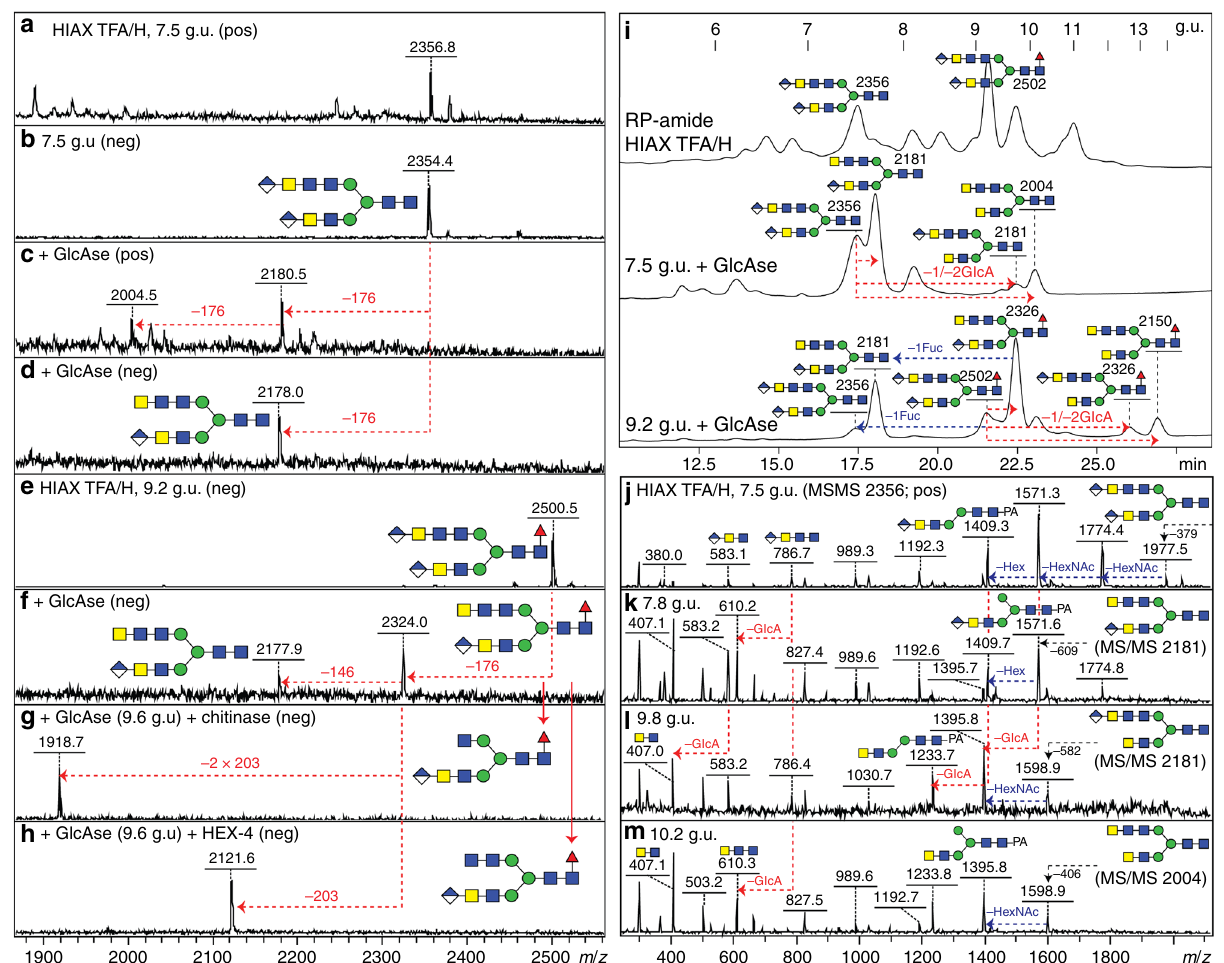
Fig. 8 Effect of glucuronidase treatment on diglucuronylated N-glycans. a – f Two RP-amide HPLC example fractions from anionic HIAX pool H (see Fig. 5) were treated for 75 min with a commercial H. pomatia β -glucuronidase (GlcAse) prior to re-analysis by MALDI-TOF – MS (see also chromatograms in i ) showing removal or one or two glucuronic acid residues (losses of 176 Da) as well as, due to an impurity in the enzyme preparation, partial defucosylation (loss of 146 Da). g , h Subsequent chitinase and HEX-4 treatment of the underlying exposed HexNAc 3 motif followed by negative mode MALDI-TOF – MS reveals that the glucuronic acid on the upper antenna substitutes a GalNAc β 1,4GlcNAc β 1,4GlcNAc motif, which correlates also with LC – MS n data (see Fig. 7). i Removal of glucuronic acid and fucose (as de fi ned by changes in m / z as shown in c , d and f ) correlates with shifts in RP-amide HPLC elution time as compared to the original chromatogram for anionic HIAX pool H (see arrows showing the forward shift caused by defucosylation (blue) and the backward shift after deglucuronylation (red), which is larger when the GlcA residue is lost from the lower arm); structures are annotated with m / z values for the [M + H] + ions. j – m Positive mode MALDI-TOF – MS/MS of the 7.5 g.u. glycan before and after glucuronidase treatment revealing differences in fragmentation between the original glycan ( j ) and the partially ( k and l ) and fully deglucuronylated ( m ) products of different elution times; key changes in the B- and Y-fragments are indicated (e.g. loss of B-ions at m / z 583 and 786, appearance of ones lacking glucuronic acid at m / z 407 and 610 and shifts in the pyridylamino-containing Y-ions). For the MS/MS of the untreated and treated forms of the m / z 2502 glycan (refer to Fig. 6k and